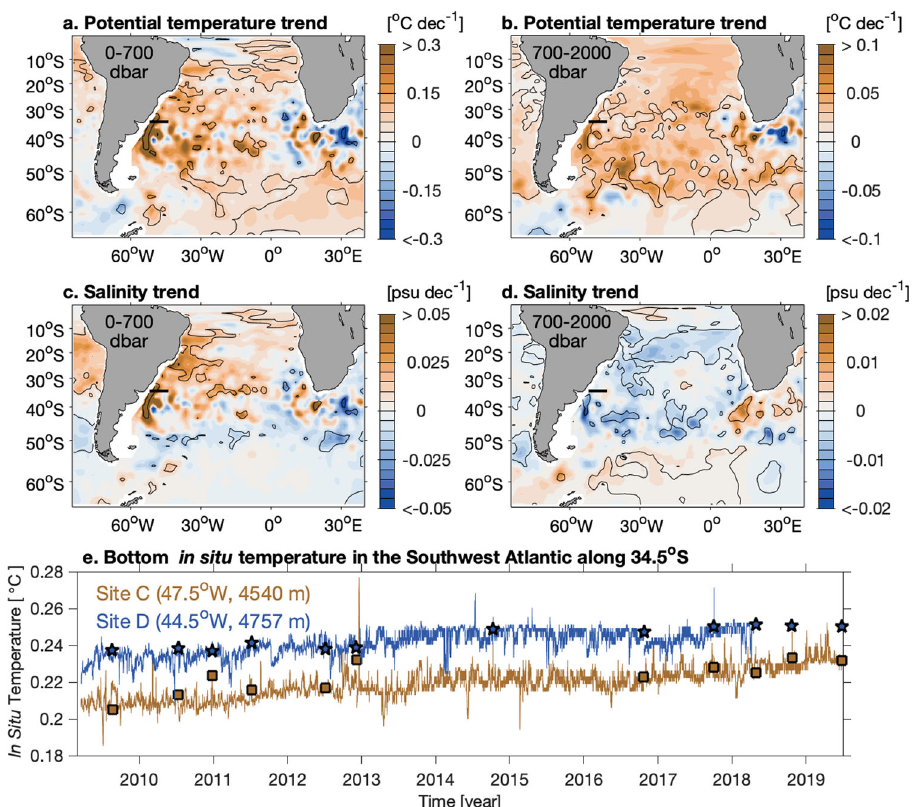
Fig. 3 Temperature and salinity trends in the South Atlantic. a , b Trends of temperature averaged over the top 700 dbar and between 700 and 2000 dbar. c , d Trends of salinity averaged over the top 700 dbar and between 700 and 2000 dbar. The decadal linear trends in ( a – d ) are computed from annual Argo climatology 246 for the years 2004 – 2018. Black contour lines indicate trends that are signi fi cant at the 90% con fi dence level. The black horizontal line indicates the position of the western SAMBA moorings at 34.5°S. e In situ hourly bottom temperature data from western SAMBA moorings 75 at 47.5°W (Site C; brown curve) and 44.5°W (Site D; blue curve) from March 2009 to June 2019. Squares and stars are corresponding hydrographic measurements during research cruises used to calibrate the mooring data at 47.5°W and 44.5°W,